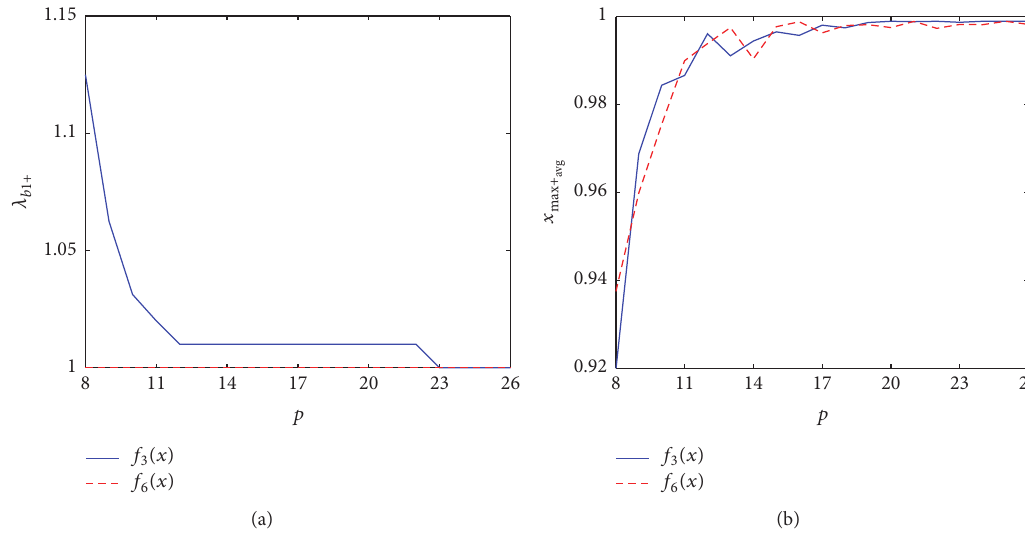
Figure 7: The key-points of the bifurcation diagram for the two positive control parameter map versions 𝑓 3 (𝑥) and 𝑓 6 (𝑥) at different precisions. (a) The first bifurcation point. (b) The average maximum